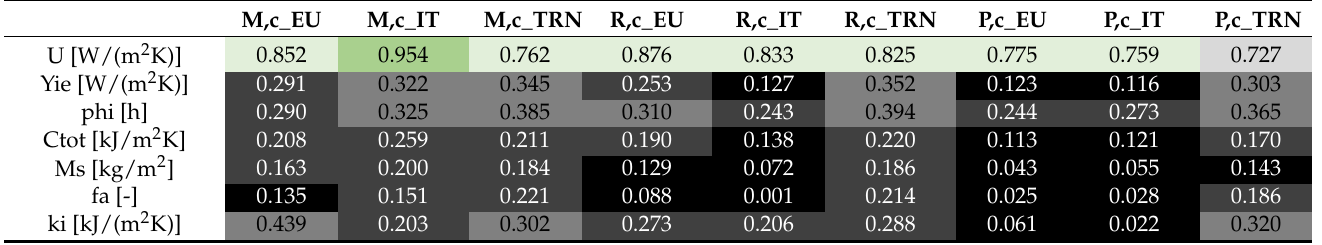
Table A3. Weight analysis of the thermo-physical attributes of opaque structures, for the summer period and with g gl = 0.77.